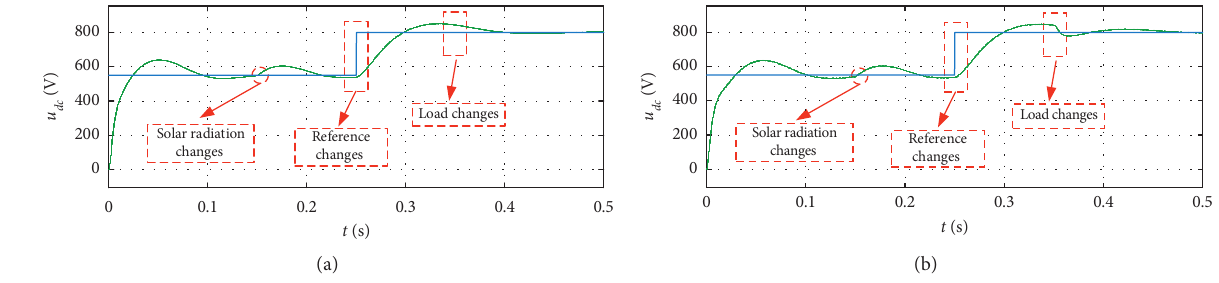
Figure 12: Changes in the DC side voltage. (a) PV. (b) PV